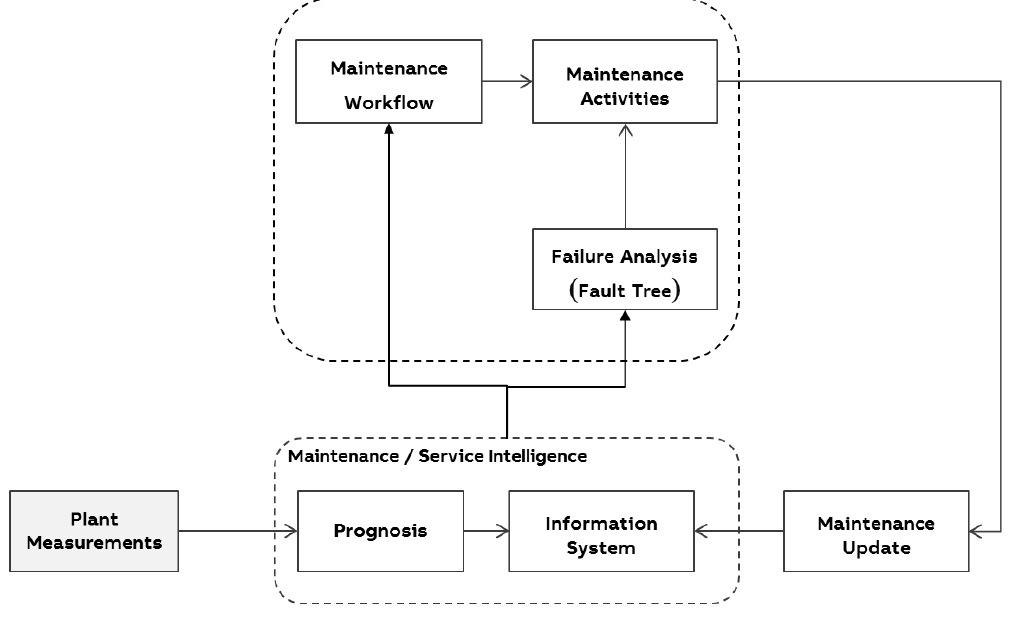
Figure 2. Condition based plant maintenance